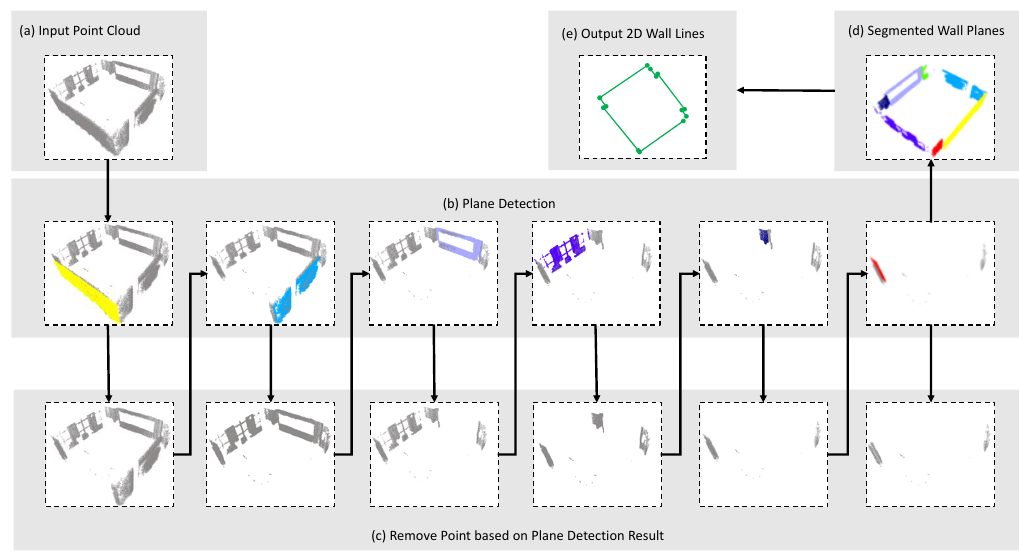
Figure 10. One detail example of 2D wall lines extraction.